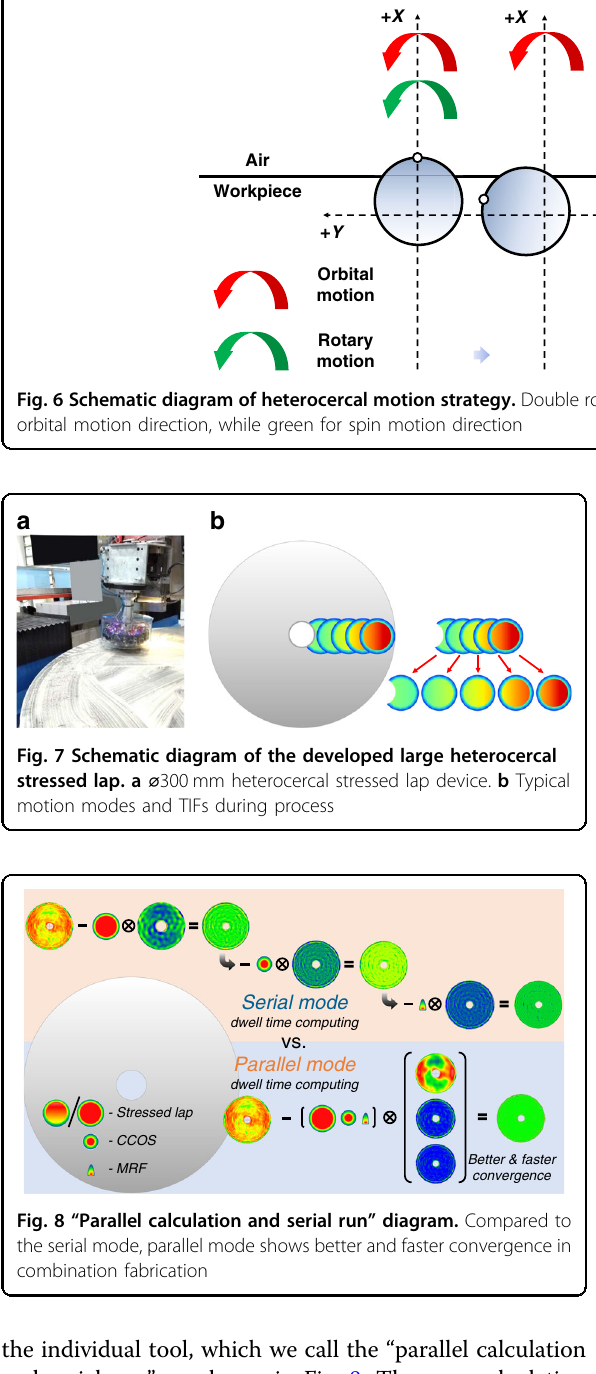
Fig. 8 “ Parallel calculation and serial run ” diagram. Compared to the serial mode, parallel mode shows better and faster convergence in combination